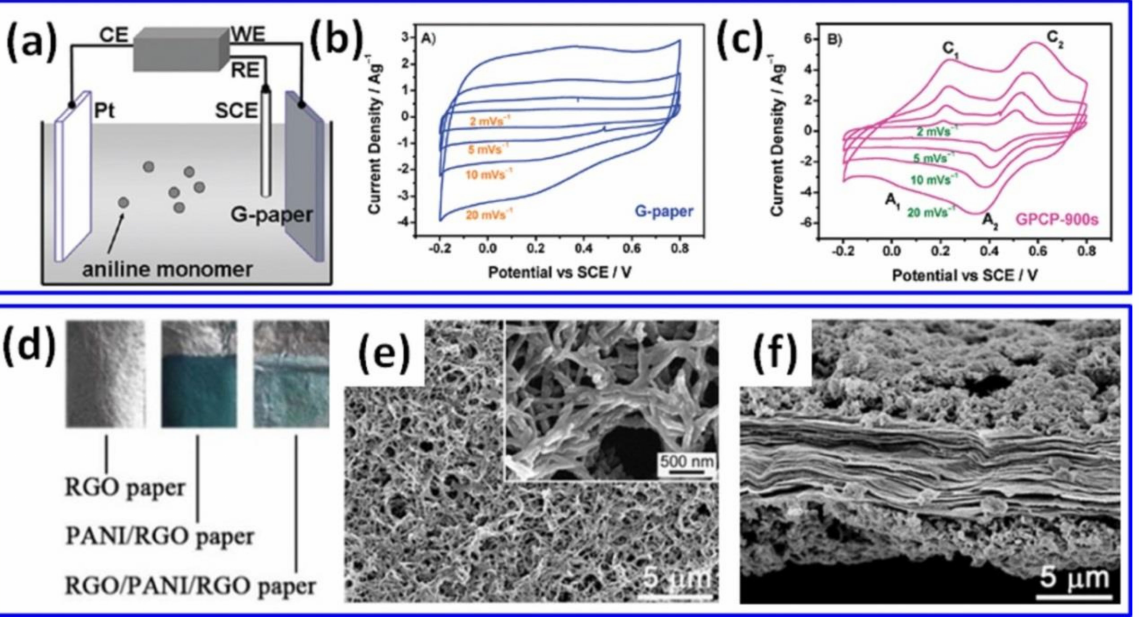
Figure 1. Illustration of the PANI EP on G-paper in the three-electrode system ( a ), cyclic voltammo- grams of G-paper ( b ) and graphene/polyaniline composite paper (GPCP) prepared by EP for 900 s ( c ) (Reprinted with permission of [43]. Copyright 2009 American Chemical Society). Photograph of rGO, PANI/rGO and rGO/PANI/rGO papers ( d ), with top view ( e ) and cross-sectional view ( f ) microstructures of PANI/rGO paper